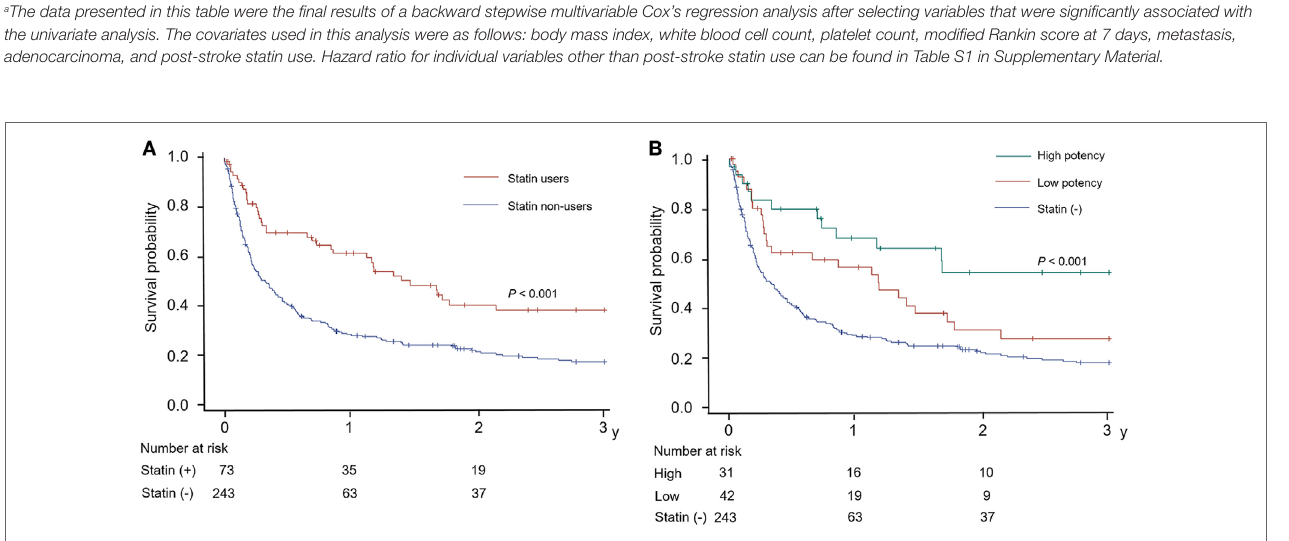
user groups (14.12 ± 19.41 µg/mL; p = 0.667). The effect of